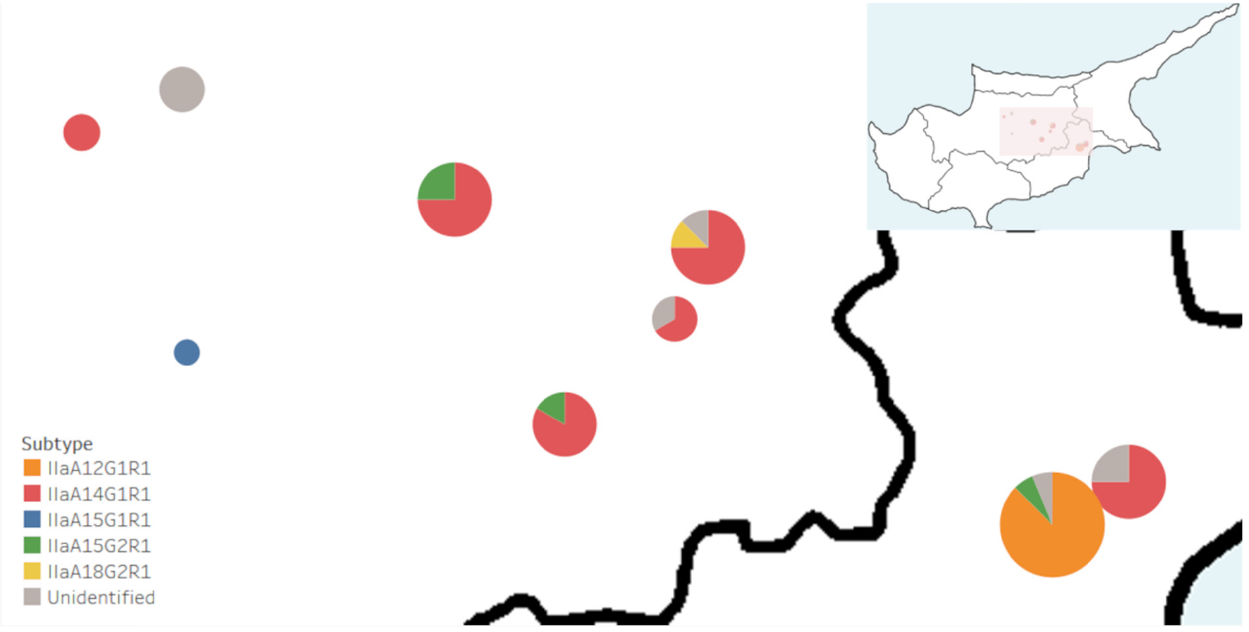
Figure 2. Cryptosporidium parvum subtype prevalence across Cypriot cattle farms. Geographical distribution of gp60 subtypes across Cyprus cattle farms: IIaA12G1R1 (orange), IIaA14G1R1 (red), IIaA15G1R1 (blue), IIaA15G2R1 (green) and IIaA18G2R1 (yellow). C. parvum -positive samples with unsuccessful gp60 sequencing are indicated in grey. Pie charts are proportional to number of C. parvum -positive samples identified per